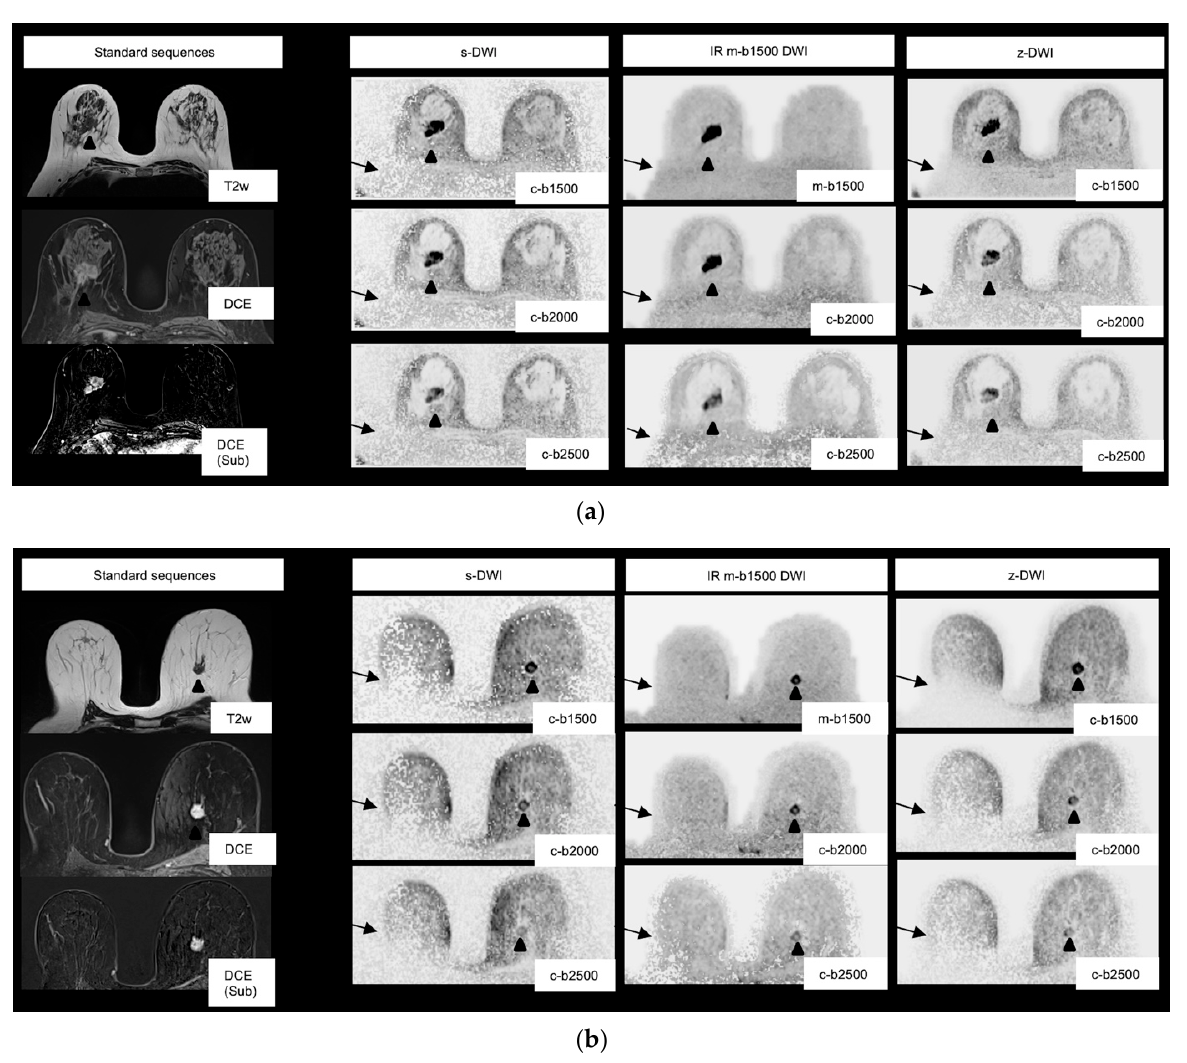
Figure 3. ( a ) Images of a 65-year-old patient with a 3.2 cm BIRADS (Breast Imaging Reporting and Data System) 5 lesion in the right breast in the 8–9 o’clock axis. Histopathology showed a ductal breast carcinoma (G3). The lesion is well-demarcated for all sequences and high b-values (arrow- heads). Overall, the black and white inverted m-b1500 sequence with a measured b1500 was pre- ferred. The signal inhomogeneities in the posterior part of the right breast are particularly reduced in the improved inversion-recovery fat-saturation diffusion-weighted-imaging (IR m-b1500 DWI) images (arrows). s-DWI: single-shot echo-planar DWI; z-DWI: zoomed DWI with spectral-attenu- ated inversion-recovery fat saturation. ( b ) Images of an 84-year-old patient with a 1.6 cm lesion in the left breast in the 11 o’clock axis. Histopathology showed a ductal breast carcinoma (G2). Noise and artifacts were rated better for the IR m-b1500 and zoomed DWI with spectral-attenuated inver- sion-recovery fat-saturation (z-DWI) images than for the single-shot echo-planar DWI (s-DWI) im- ages. Again, signal inhomogeneities in the posterior part of the right breast are particularly reduced in IR m-b1500 DWI (IR m-b1500 DWI) (arrows). The lesion is most visible in the b1500 images com- pared with the b2000/b2500 images, owing to superior lesion-to-background contrast (arrowheads). In the presence of a lesion, z-DWI with b1500 and IR m-b1500 with b1500 were pre- ferred equally often (38.3%). There was no significant difference in preference between the two most-preferred b-value and sequence combinations ( p = 1.00). In the absence of a lesion, z-DWI with b2000 was preferred most often (35%). There was no significant differ- ence in preference between the most-preferred combination (i.e., z-DWI with b2000) and the second-most-preferred combination (z-DWI with b1500; p = 0.75). The distribution of preferences in the presence of a lesion and in patients without a lesion is shown in Table 3. In seven out of sixty cases (twenty patients with lesions and three readers), a lesion was not detected with the preferred sequence and b-value combination (z-DWI with b1500: n = 4; IR m-b1500 DWI: n = 3). Table 3. Sequence and b-value preference (number of selections by each reader and the percentage of selections across all readers). (a) With a Lesion Reader